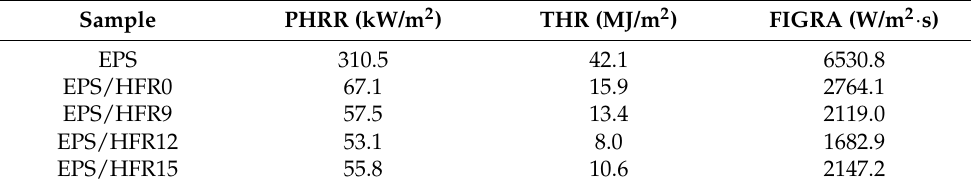
Figure 4. The cone calorimetry curves of the various EPS samples: ( a ) the PHRR curves; ( b ) the THR curves; and ( c ) the FIGRA curves. Table 2. The cone calorimeter test results for the various EPS foam samples.